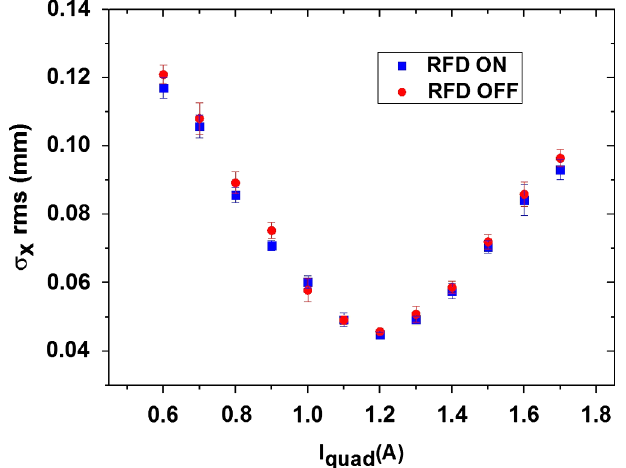
FIG. 6. Quadrupole scan comparison on screen U3 with RFD on and off in the horizontal plane.